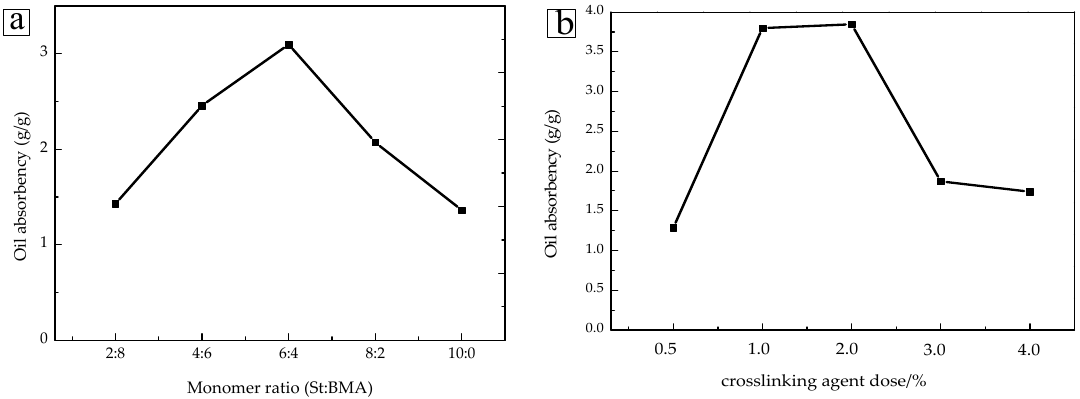
Figure 4. ( a ) Oil absorption characteristics of the P(St-BMA) microspheres at different monomer ratios and ( b ) oil absorption characteristics of the P(St-BMA) microspheres at different dosages of the DVB crosslinking agent.